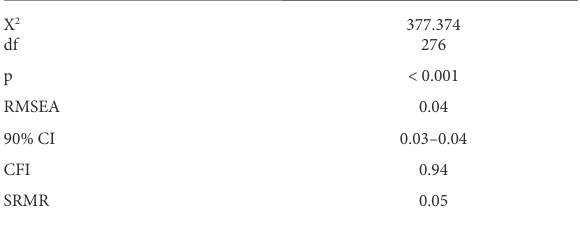
TABLE 4 Model fit statistics.